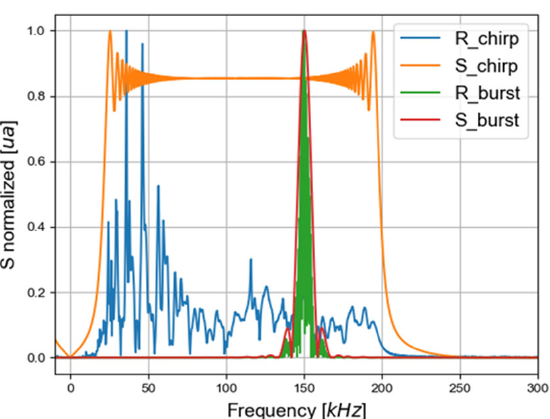
Figure 9. The FFT of the signal registered experimentally with an embedded PZT in cut-out (R_chirp), the FFT of the chirp generated experimentally (S_chirp), the FFT of the signal after convolution (R_burst), and the FFT of the burst used in the convolution (S_burst) at one point in the plate.